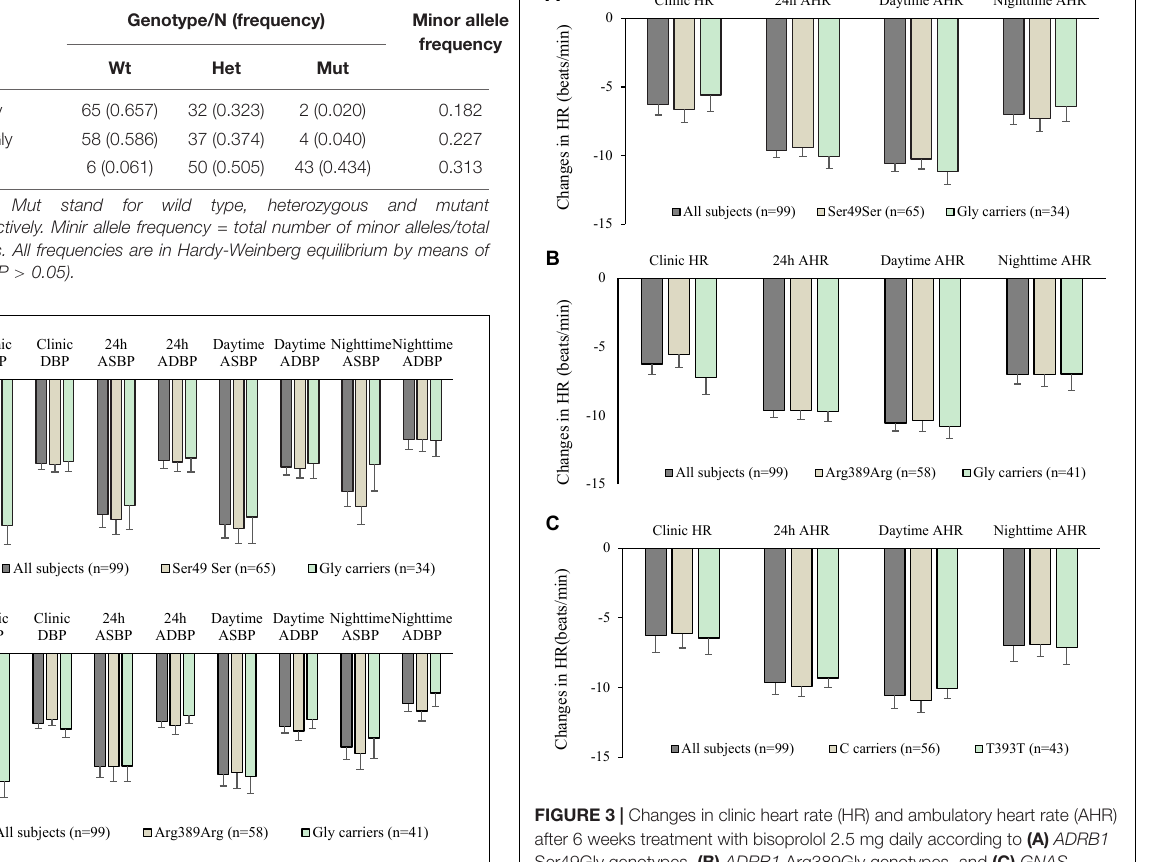
TABLE 5 | Genotype and allele frequency of the studied SNPs ( n = 99).